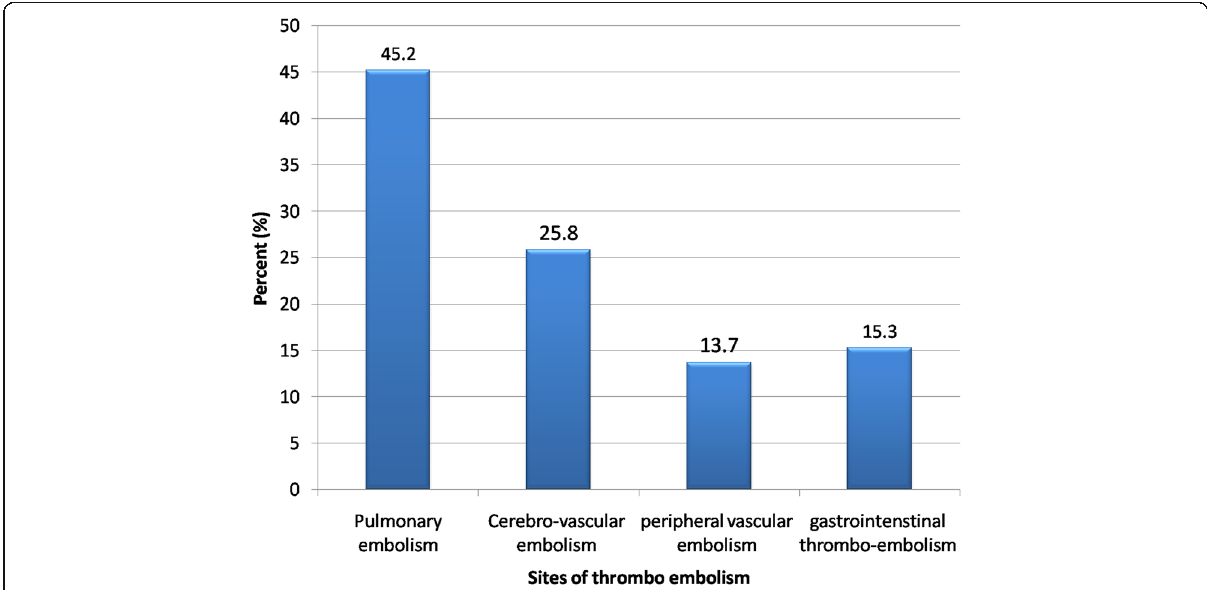
Fig. 2 Sites of thromboembolism among COVID-19